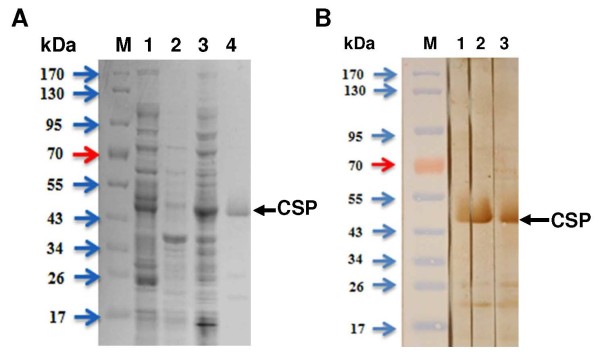
Expression of circumsporozoite protein gene in E. coli. (A) Purification of recombinant circumsporozoite protein with Ni-NTA agarose affinity chromatography. Lane M, Molecular weight protein marker; lane 1, induced E. coli DH5α cell lysate with IPTG; lane 2, flow-through; lane 3, wash; lane 4, elute. (B) Western blot analysis of recombinant circumsporozoite protein. M, Molecular weight protein marker; lanes 1–3, patients with malaria.